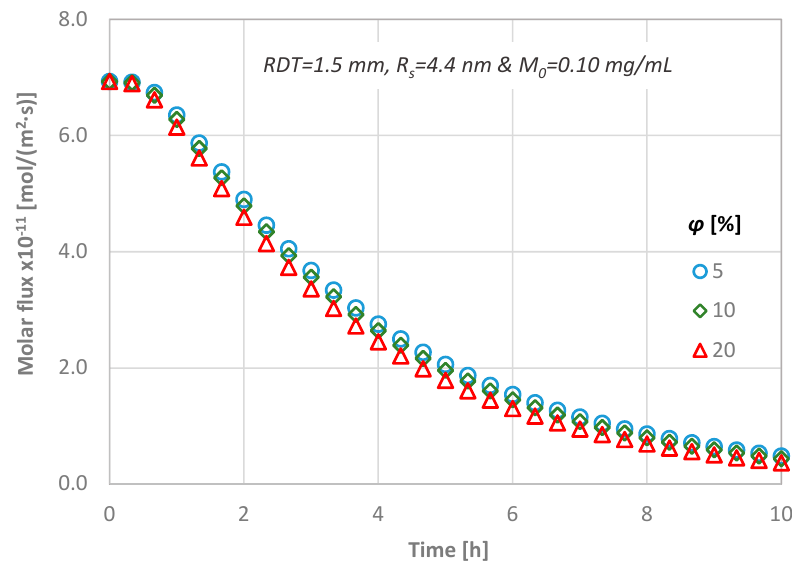
Figure 12. Temporal molar flux distribution for three different porous discs ( RDT = 1.5 mm, R s = 4.4 nm and M 0 = 0.10 mg/mL).